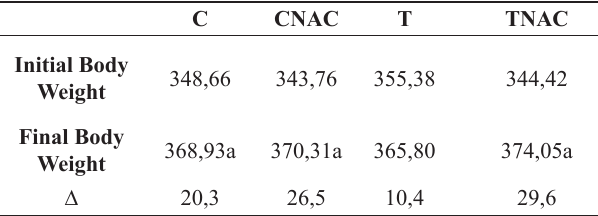
Table 3. Alterations in body weight in different